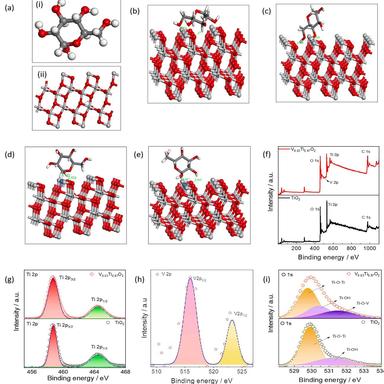
(a)-(i) Optimized structure of D-Glucose; (ii) Optimized surface of (101) of TiO2; Adsorption of D-Glucose on the surface of (101) of (b) TiO2; (c) V0.03Ti0.97O2; (d) Co0.02Ti0.98O2; (e) Ni0.03Ti0.97O2; XPS of V0.03Ti0.97O2 and TiO2 (f) Survey; (g) Ti 2p; (h) V 2p; (i) O 1s.